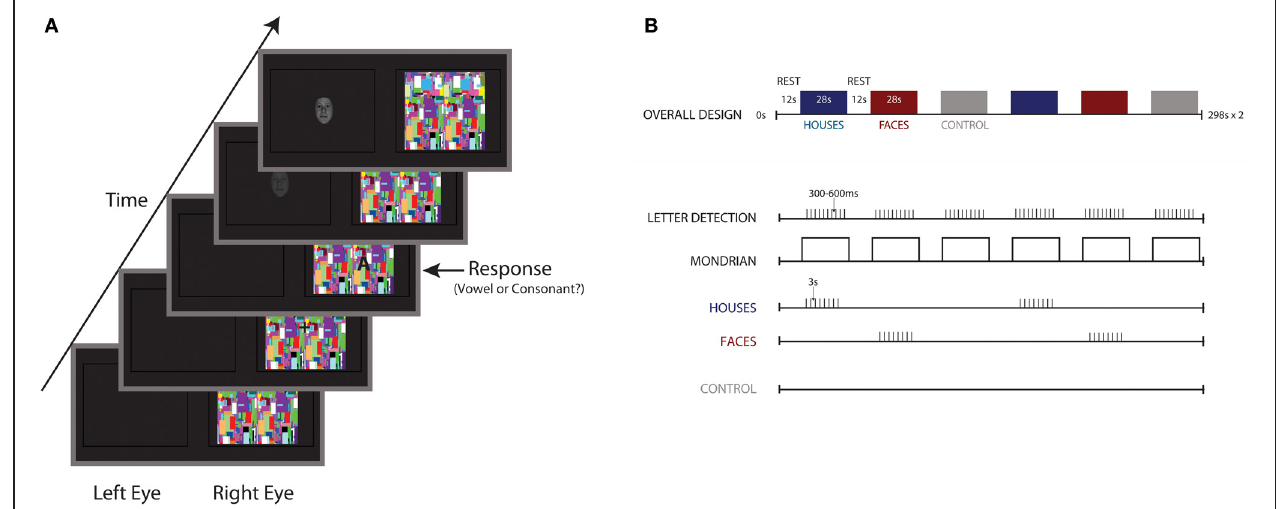
Overall blockdesign, with28-sblocks ofnoise images separated by12sofrest. Ten letters were presented for a duration of 1500ms each, with letter onset jittered by 300–600 ms. Eight houses or fearful faces appeared within each block, with block order counterbalanced and randomized across